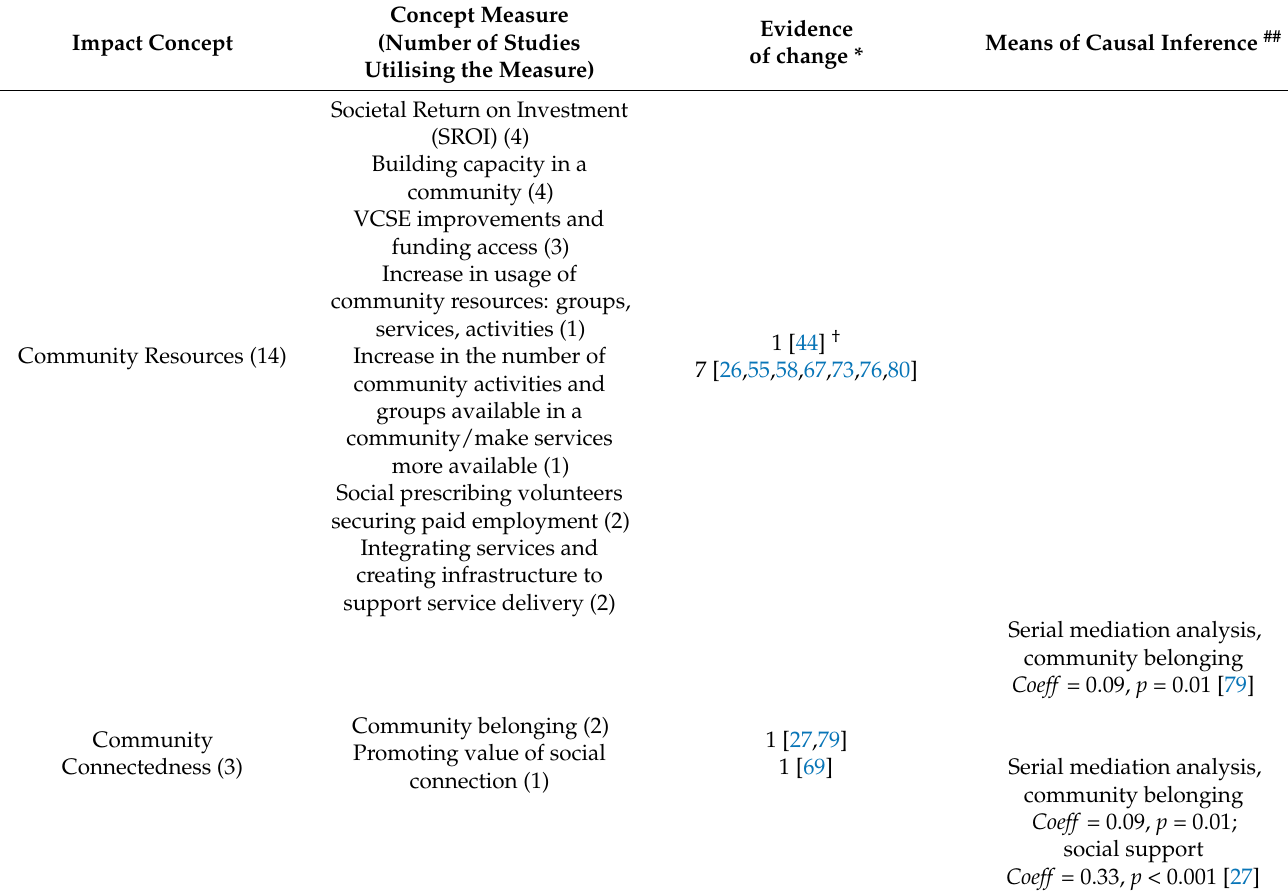
Table 3. Summary table of 18 articles that evaluate social prescribing programmes according to community-level outcomes.